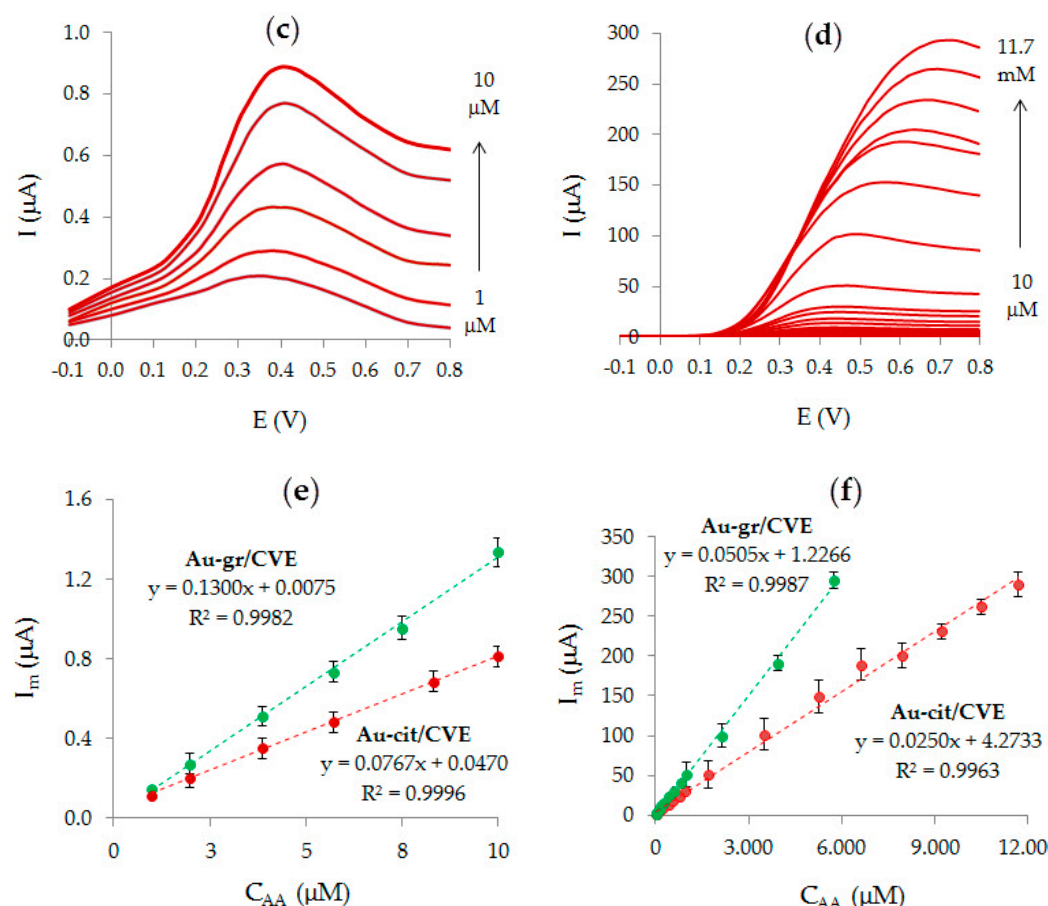
Figure 8. AA voltammograms on Au-gr/CVE ( a , b ) and Au-cit/CVE ( c , d ) at different AA concentrations and corresponding dependences I m vs C AA on Au-gr/CVE and Au-cit/CVE ( e , f ).